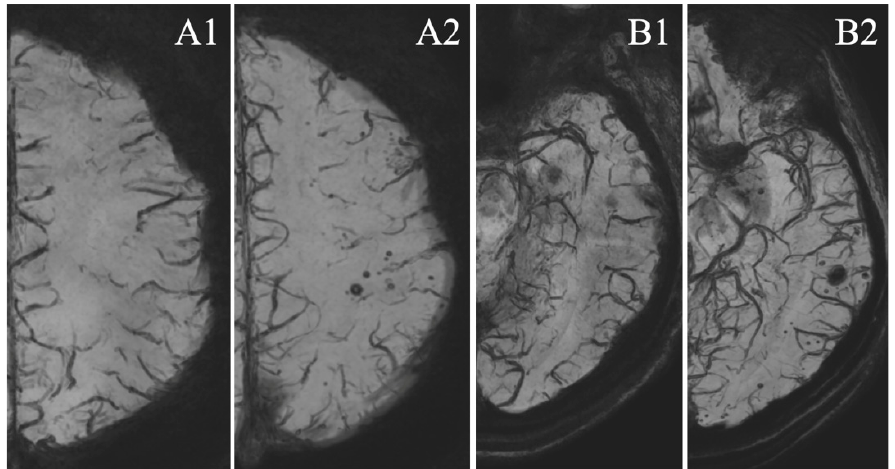
Figure 1. MSA appearance. Axial ten millimeters minimum intensity projection (Mini-IP) recon- structions of magnetic resonance imaging (MRI), susceptibility weighted imaging (SWI) sequence of the same patient. ( A1 ) and ( B1 ) Pretreatment scans, ( A2 ) and ( B2 ) follow-up at 36 months after treatment by stent (flow diverter, FD) of a left posterior communicating artery aneurysm. Notice